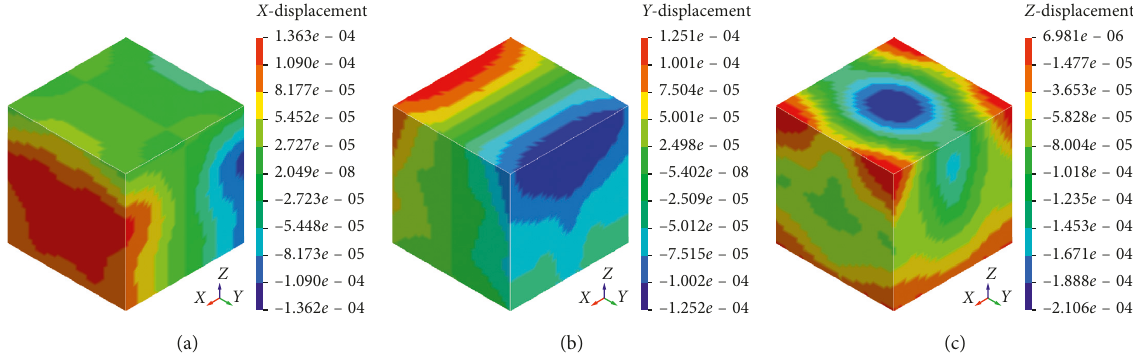
Figure 5: Displacement of dynamic and static combined loading model. (a) X -displacement. (b) Y -displacement. (c) Z